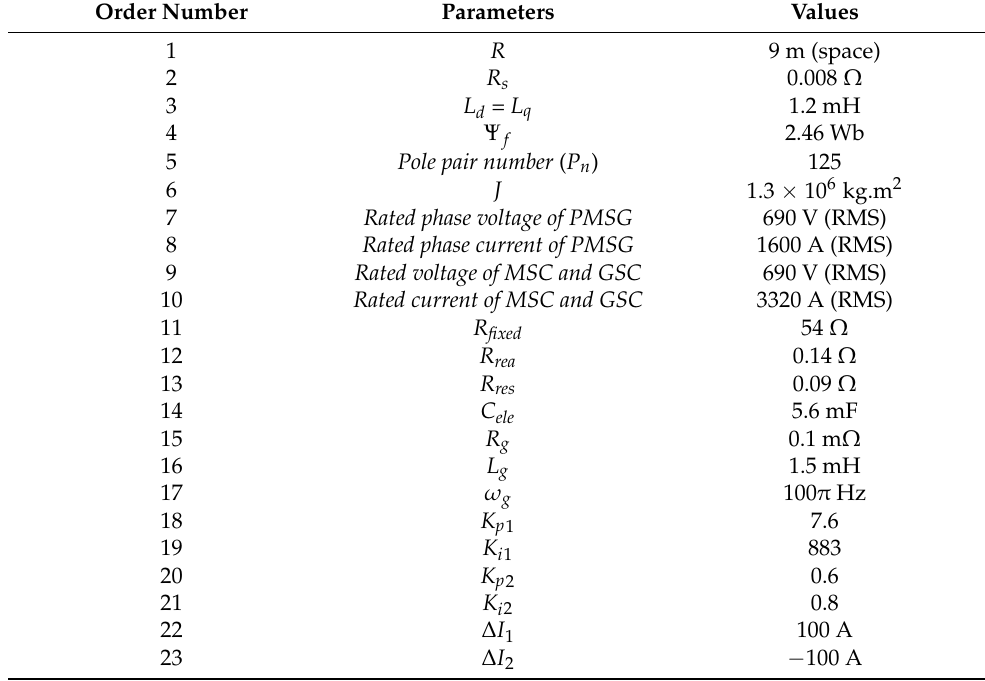
Table A1. Main simulation parameters of the